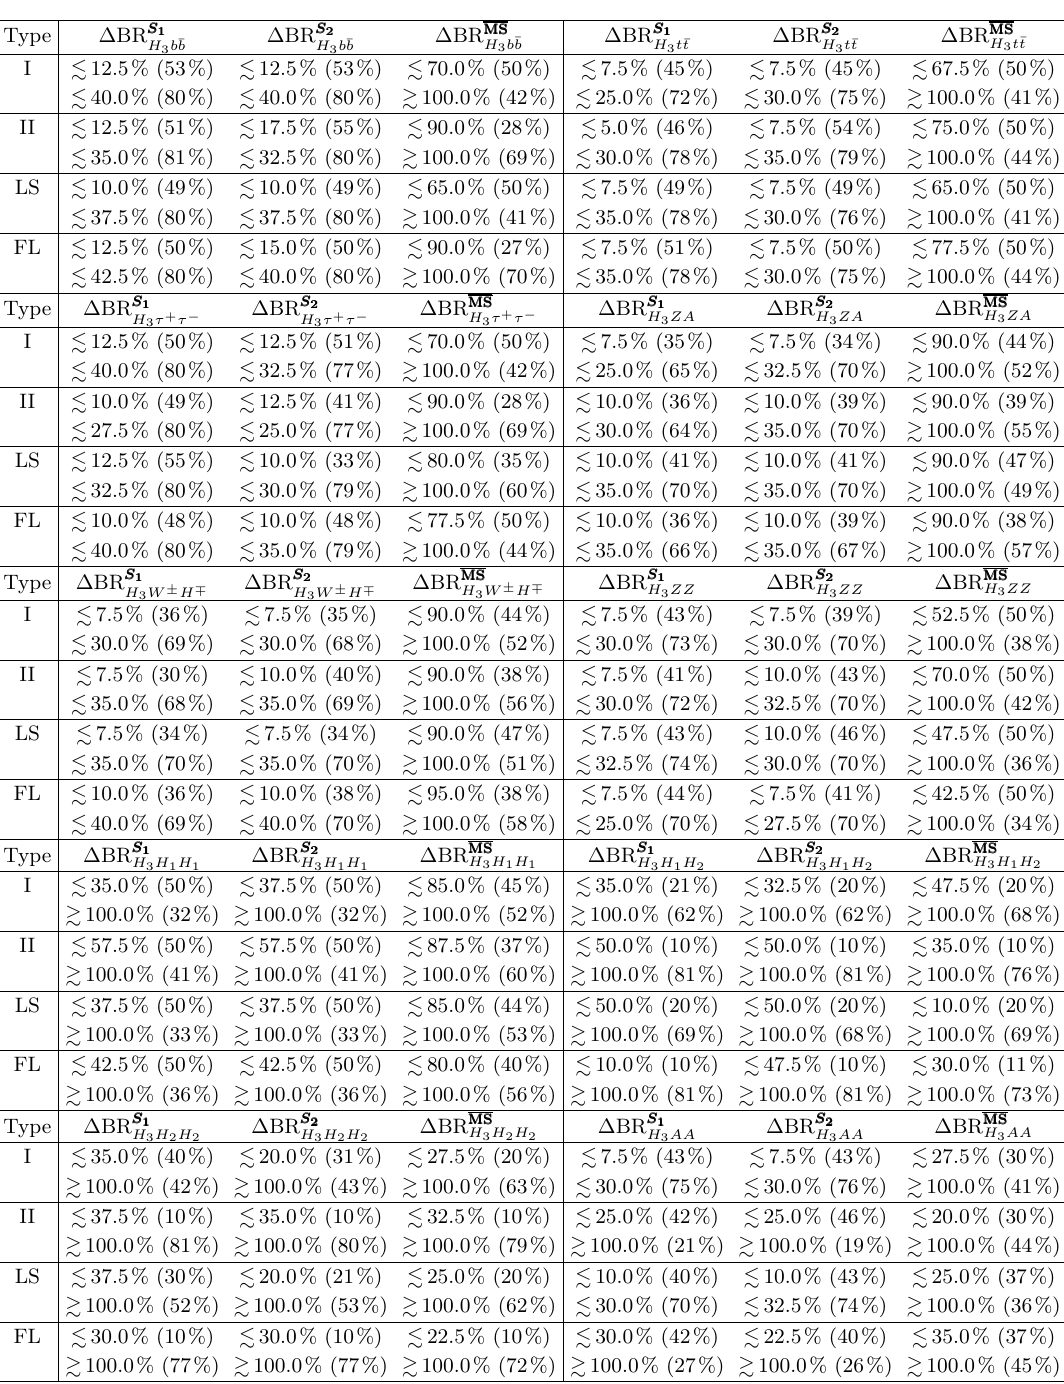
Table 21 . Relative size of the EW corrections to the BRs of the non-SM-like N2HDM Higgs boson H 3 ( H 1 is SM-like) into b (cid:22) b , t (cid:22) t , (cid:28) + (cid:28) (cid:0) , ZA , W (cid:6) H (cid:7) , ZZ , H 1 H 1 , H 1 H 2 , H 2 H 2 , and AA for the four N2HDM types I, II, LS and